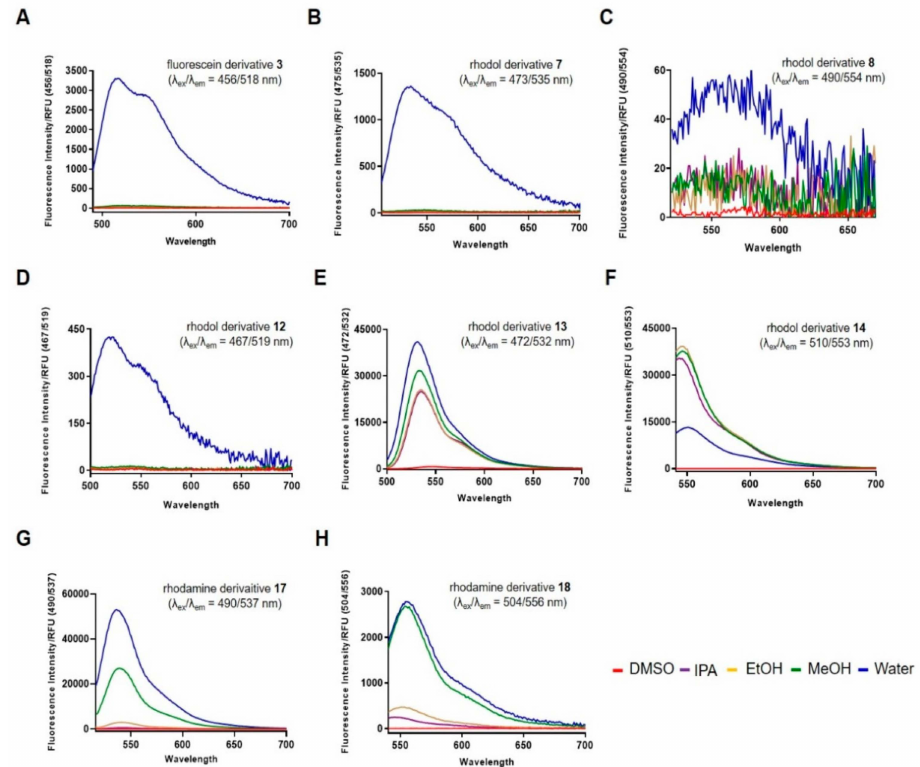
Figure 5. Solvent e ff ect of asymmetric and reduced xanthene fluorophores (1.0 µ M) in DMSO, IPA, EtOH, MeOH, and water. ( A ) fluorescein 3 ( λ ex / λ em = 456 / 518 nm); ( B ) rhodol 7 ( λ ex / λ em = 473 / 535 nm); ( C ) rhodol 8 ( λ ex / λ em = 490 / 554 nm); ( D ) rhodol 12 ( λ ex / λ em = 467 / 519 nm); ( E ) rhodol 13 ( λ ex / λ em = 472 / 532 nm); ( F ) rhodol 14 ( λ ex / λ em = 510 / 553 nm); ( G ) rhodamine 17 ( λ ex / λ em = 490 /